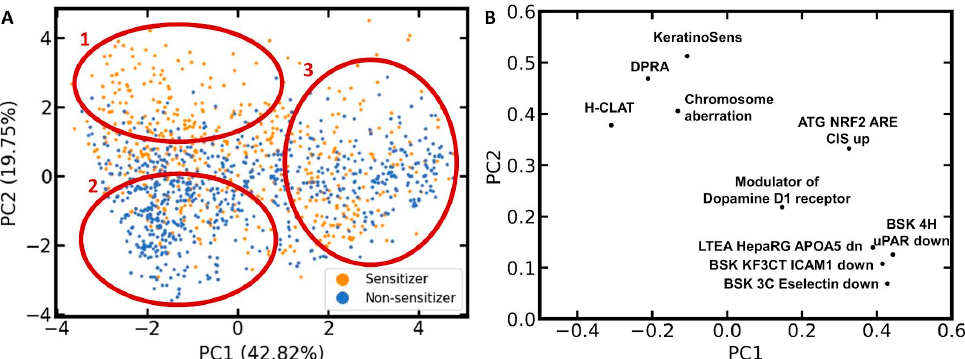
Figure 4. LLNA data set analyzed by PCA in the feature space of the ten selected bioactivity descriptors. ( A ) Scatter plot colored by the binary skin sensitization potential; ( B ) loadings plot of the ten descriptors. The percentages in parentheses report the variance explained by the respective principal component (PC). Note that the axis sections differ for panels ( A,B ).